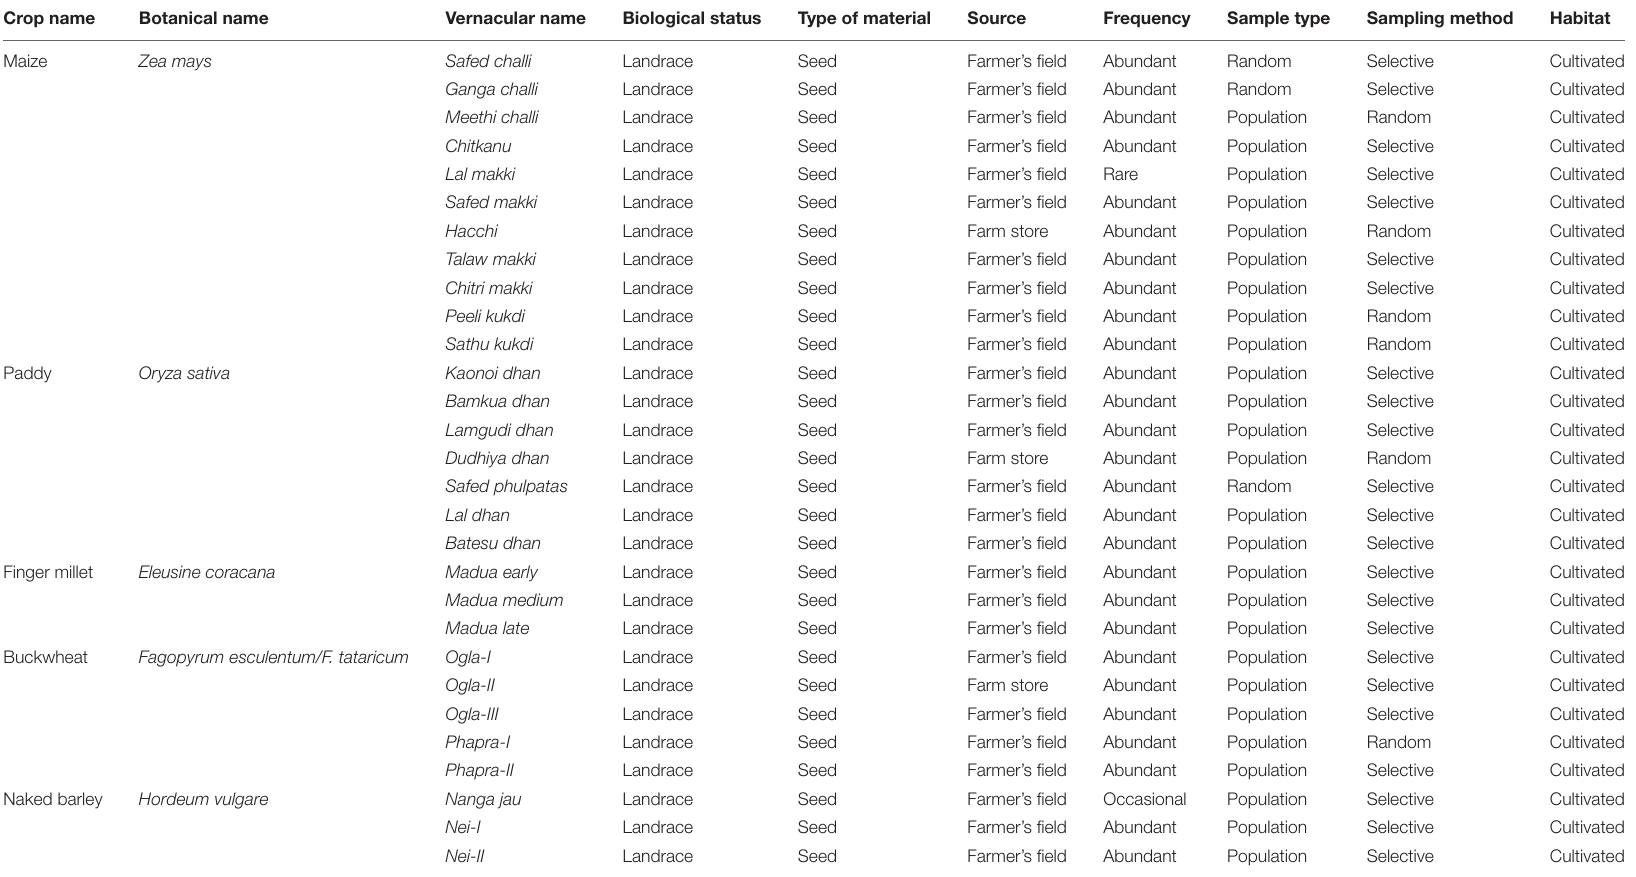
TABLE 1 | Summary of the passport information of traditional crop landraces collected from northwest Himalayas of